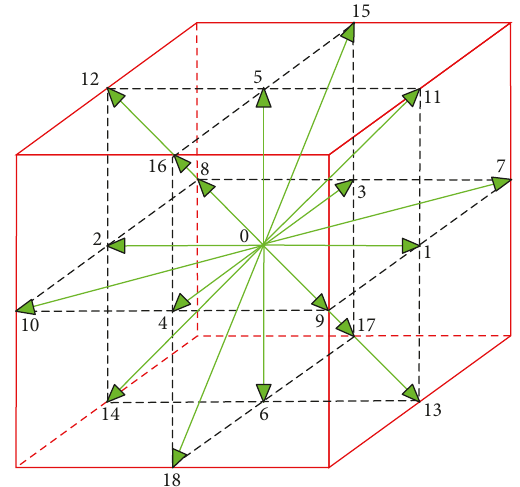
Figure 1: D3Q19 model of 19 velocities in